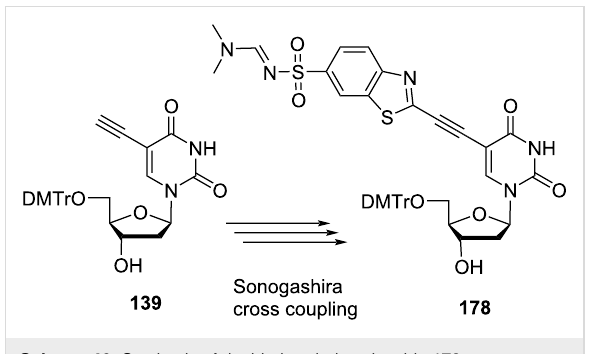
Scheme 46: Synthesis of double-headed nucleoside 178